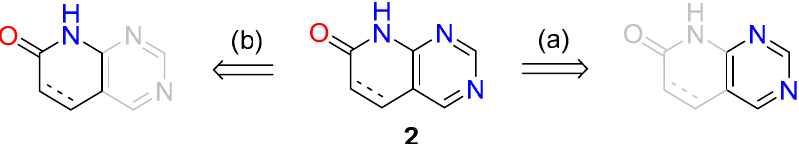
Figure 7. Synthetic approaches for pyrido[2,3- d ]pyrimidin-7(8 H )-ones ( 2 ): ( a ) from a preformed pyrimidine and ( b ) from a preformed pyridone .